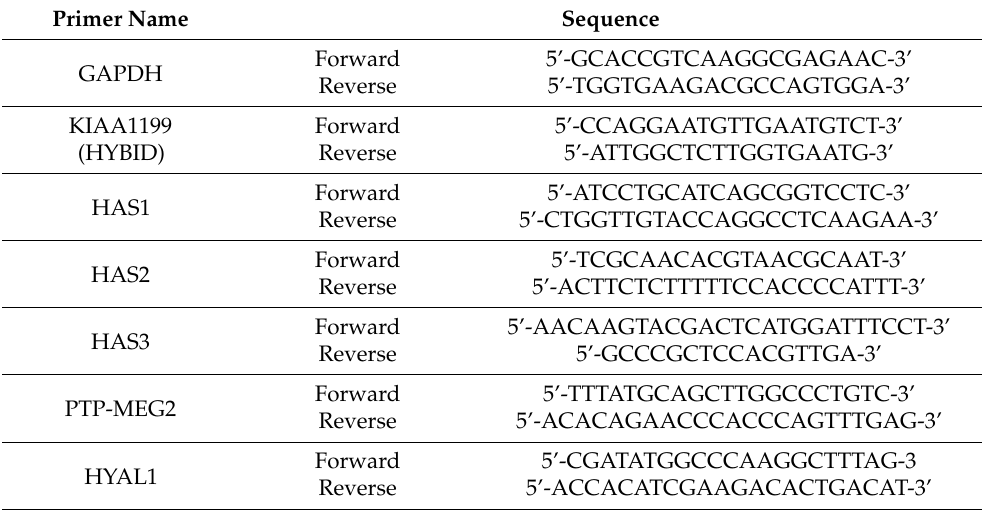
Table 1. Primers used in this